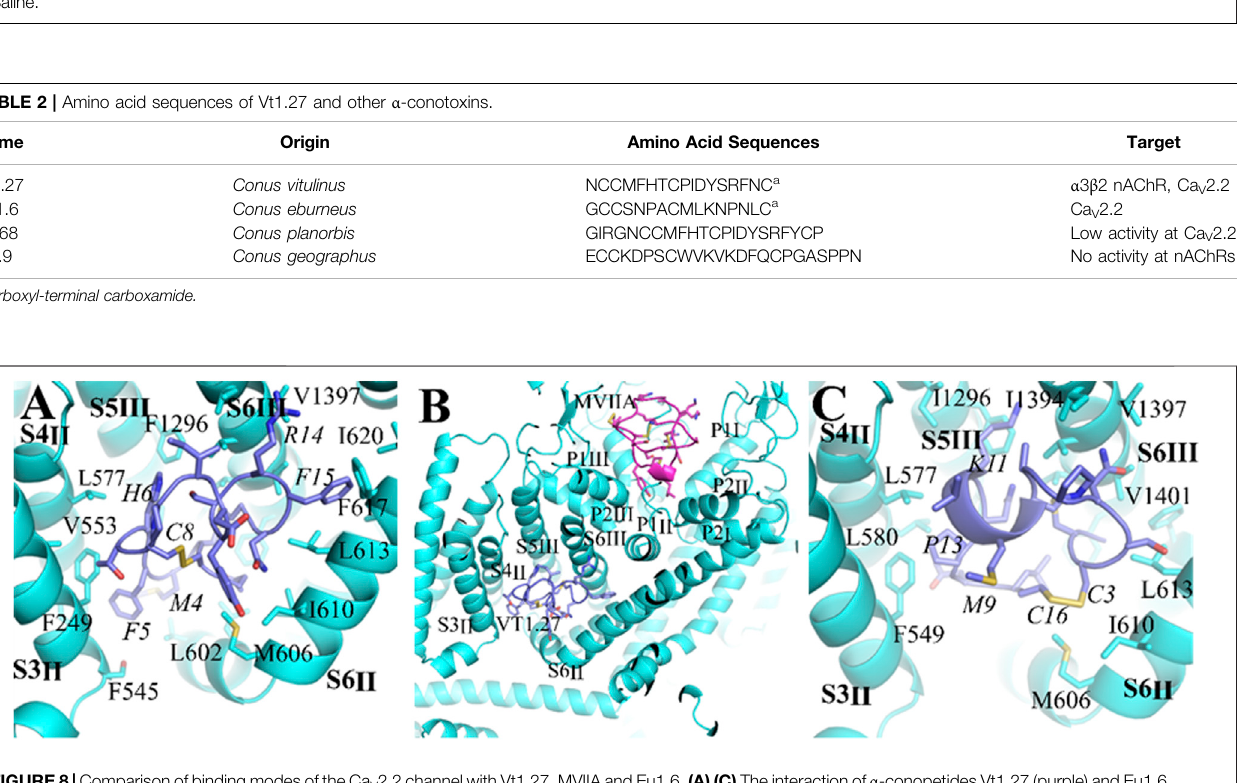
FIGURE 7 | Anti-allodynic effects of Vt1.27 in rat PNL and CCI pain models. PNL (A) and CCI (B) rats ( n = 8/group) treated with sterile saline (i.m.), Vc1.1 (12 nmol/kg, i.m.), and Vt1.27 (0.24, 1.6, and 12 nmol/kg, i.m.). The bar graph shows the mean pain threshold (g) pre-injection and at 2 h, 4 h following different treatments.Thedifferentgroupswereanalyzed byone-wayANOVAfollowedbytheLSD testformultiplecomparison testsat the0.05level ofsigni fi cance. # p < 0.05 vs . Saline.